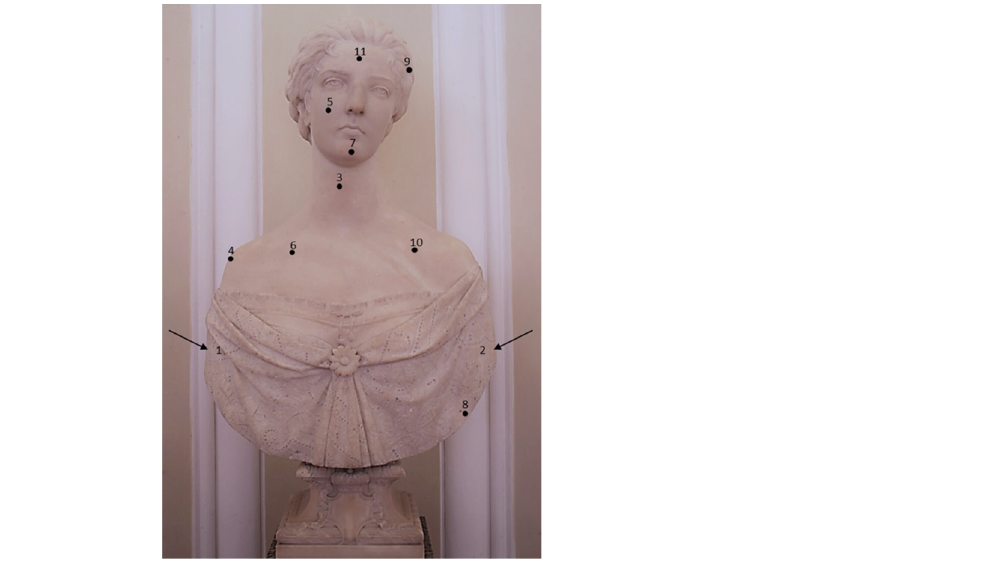
Table 1. Measure points summary, corresponding statue areas and analytical techniques used.